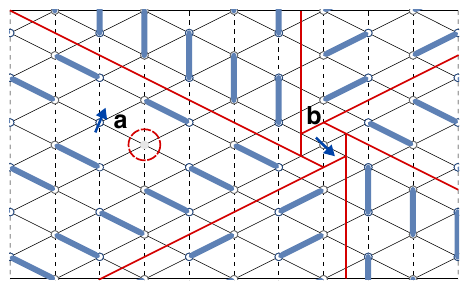
Fig. 3 Local valence bond defects. Illustrated are two mechanisms for formation of local spin moments on the anisotropic triangular lattice, with singlet bonds indicated in blue and domain walls between valence bond patterns indicated in red. a Local spin 1/2 caused by the breaking of a singlet bond due to an anion layer vacancy, emphasized by the red circle. b Local spin 1/2 due to a defect in a quasi-static valence bond singlet